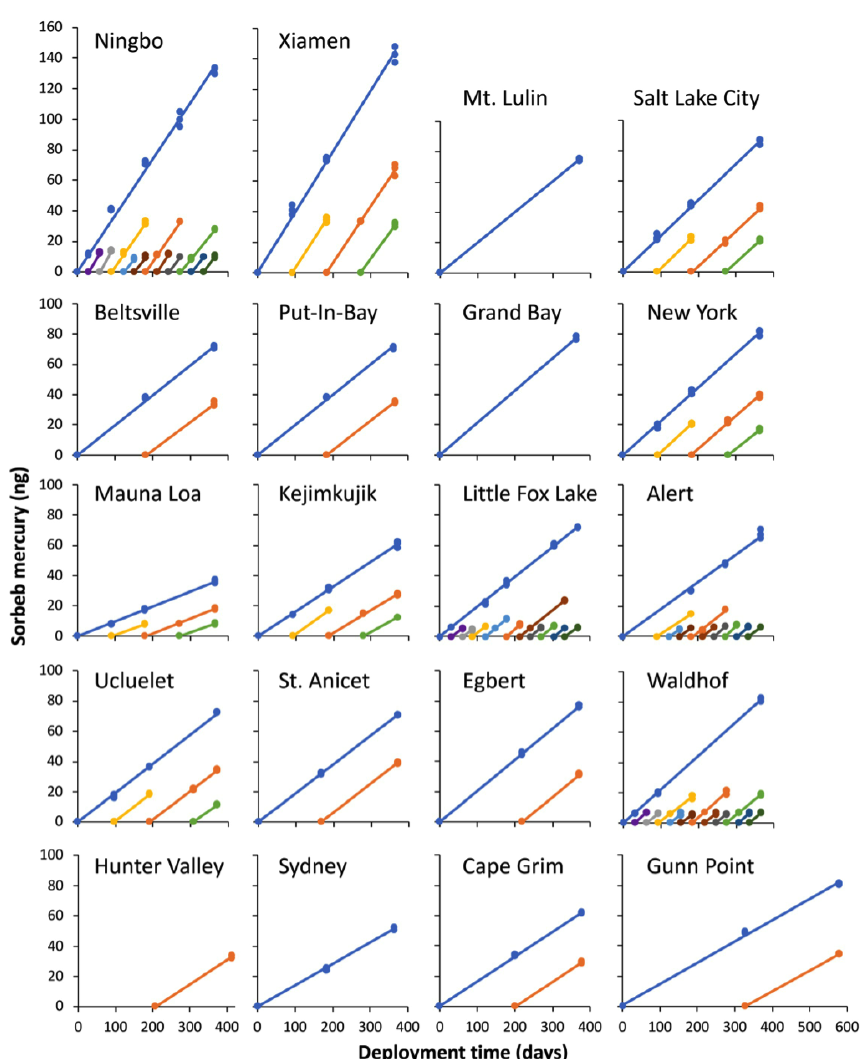
Figure 2. Uptake curves and individual deployments of passive air samplers across all 20 sampling locations. 0ng points mark the beginning of deployments. All samples on the same line are for deployments that began at the same time. All axes are scaled the same. Deployments of the same colour cover equivalent deployments periods (i.e. orange is 7–12-month deployment at all